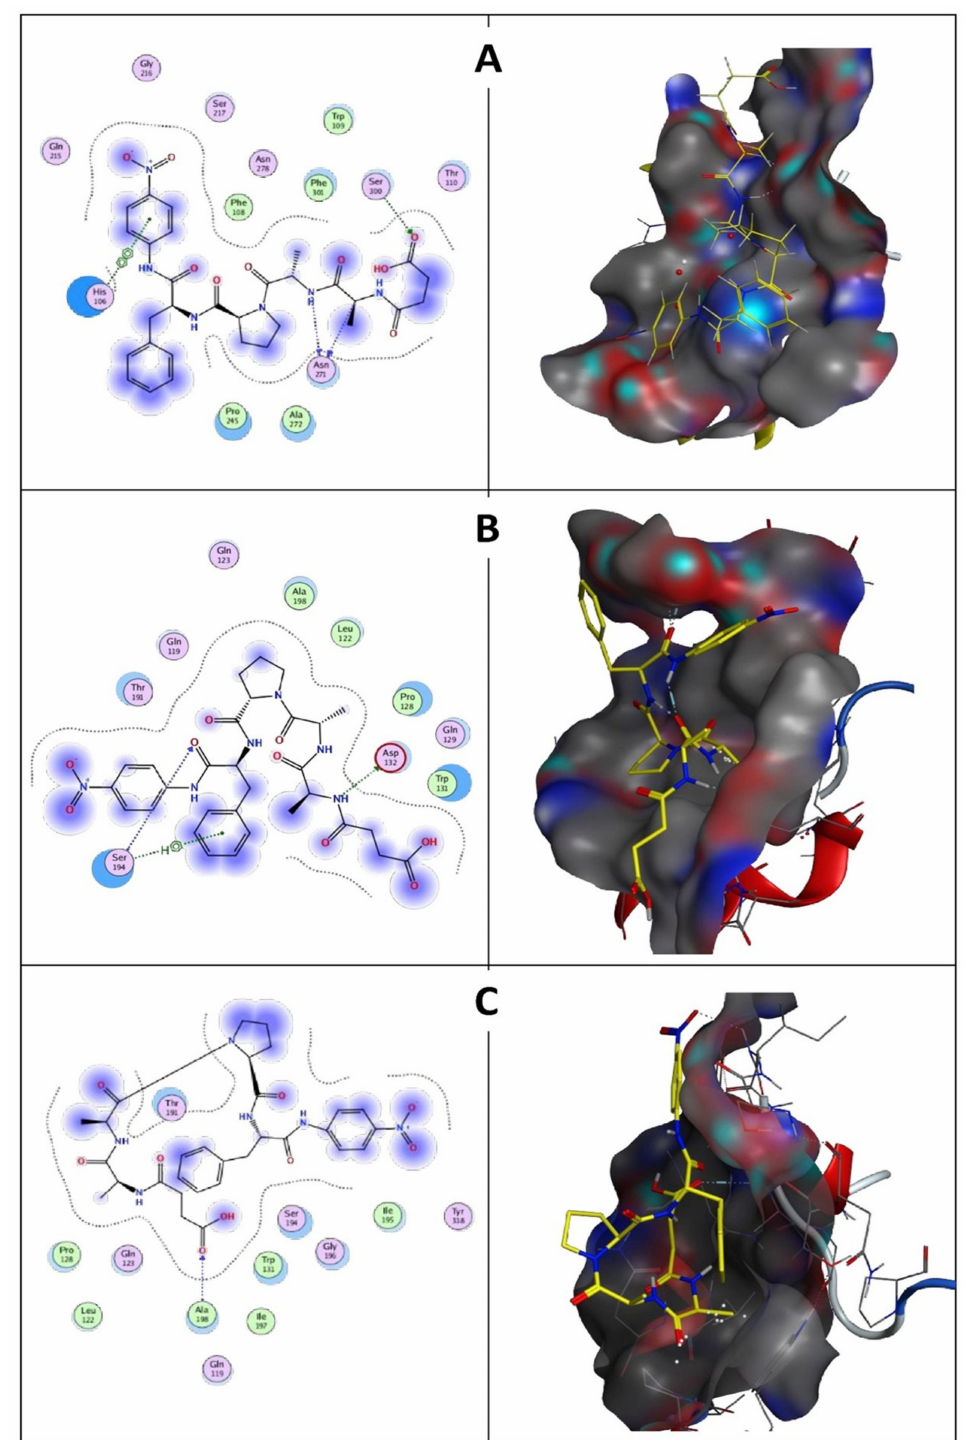
Figure 13. ( A ) Wild keratinase ligand interaction: left is the 2D structure and right is the 3D structure. Ligand has three hydrogen bonds: one with Ser 300 and two with Asn 271. ( B ) D 137 N keratinase ligand interaction: left is the 2D structure and right is the 3D structure. Ligand has two hydrogen bonds: Asp 132 and Ser 194. ( C ) The 7 mutants keratinase ligand interaction: left is the 2D structure and right is the 3D structure. Ligand has one hydrogen bond with Ala